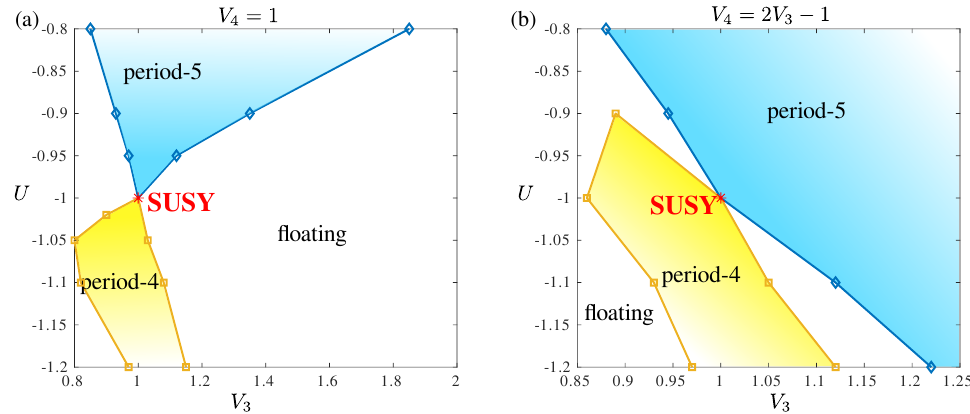
Figure 12: Phase diagram of constrained fermion model Eq. (4) on a zig-zag ladder as a function of third nearest neighbor interaction V = 1 and (b) V = 2 V − 1. The location of these cuts on a V V 4 4 3 with the dash-dotted lines in Fig.10. These two phase diagrams are extracted with N = 201 and fixed boundary conditions with the edge sites